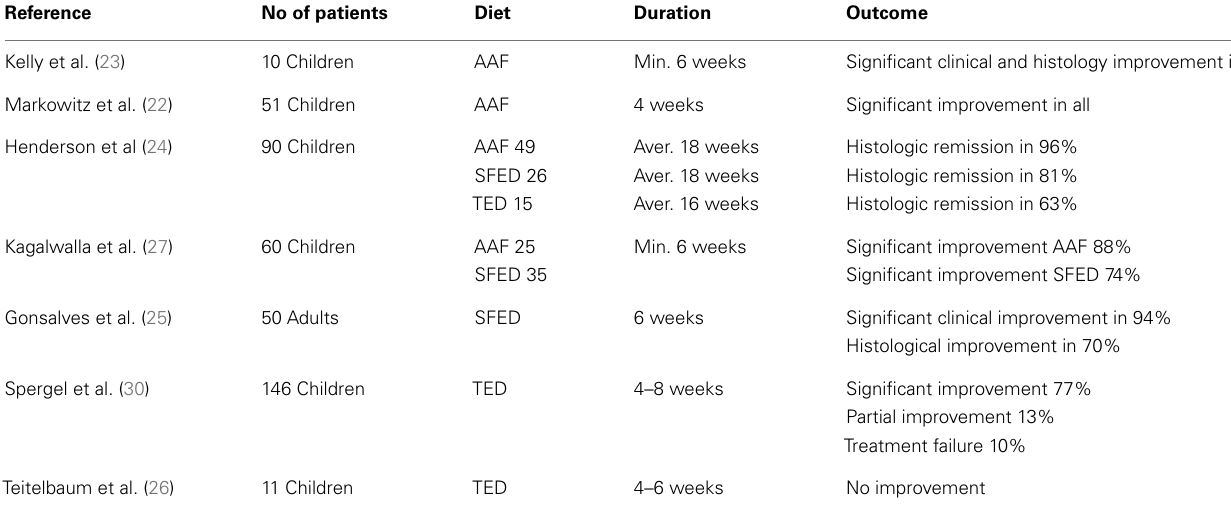
Table 1 | Outcomes of studies on dietary treatment of eosinophilic esophagitis